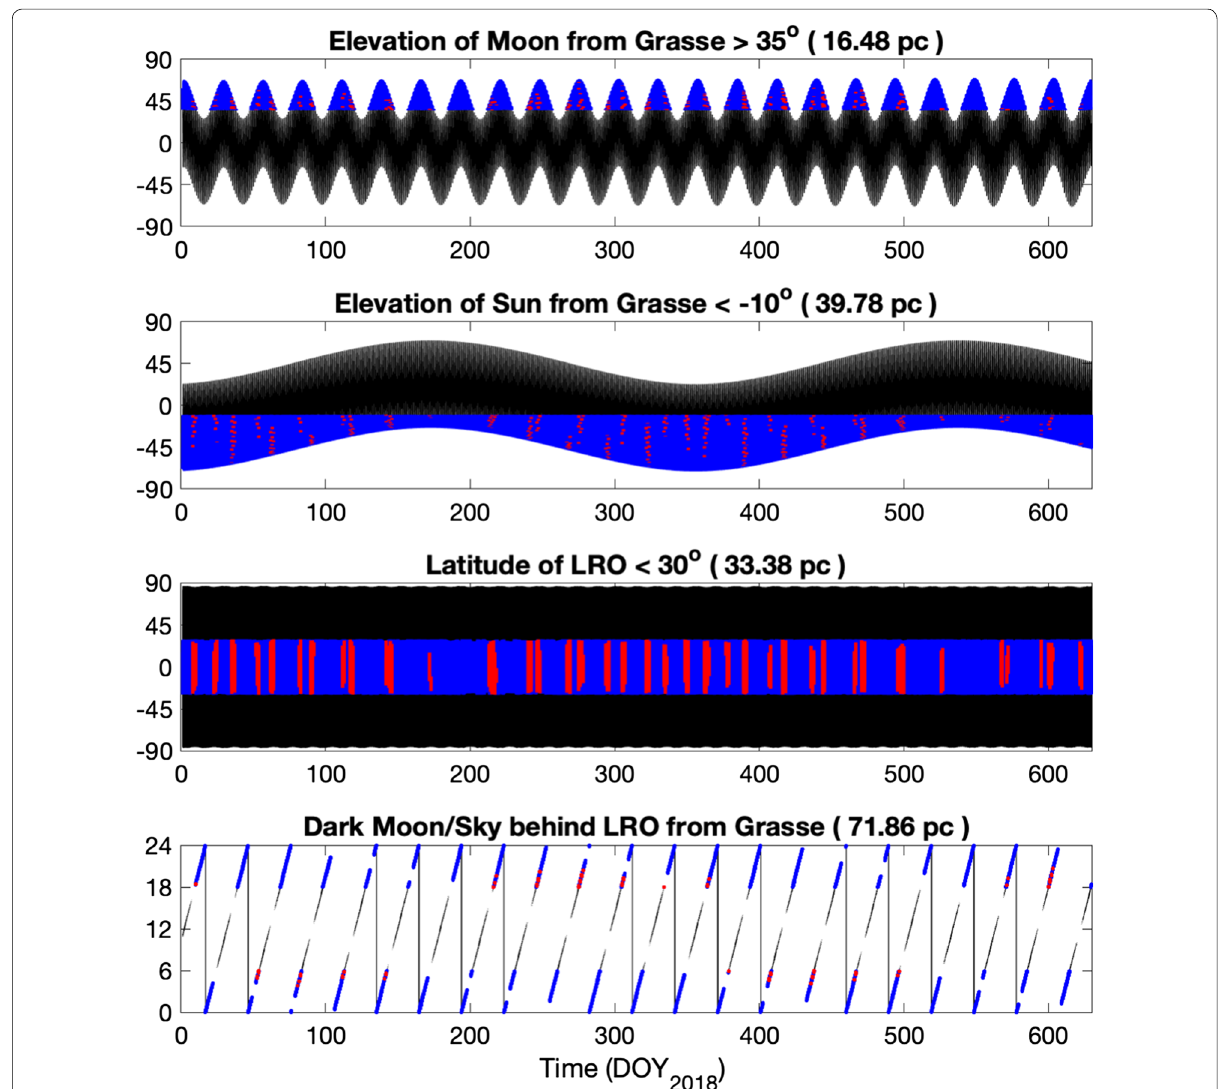
Fig. 7 Evolution of key geometry parameters. These are shown for the LRO‑Grasse opportunities, between January 1, 2018 and September 22, 2019. The black lines give the complete time series of these parameters, and the blue lines the segments where the constraint on that parameter is satisfied. Their total duration relative to the time span is given in parenthesis as a percentage. The red lines indicate the periods where all four constraints are satisfied and thus when passive ranging may be